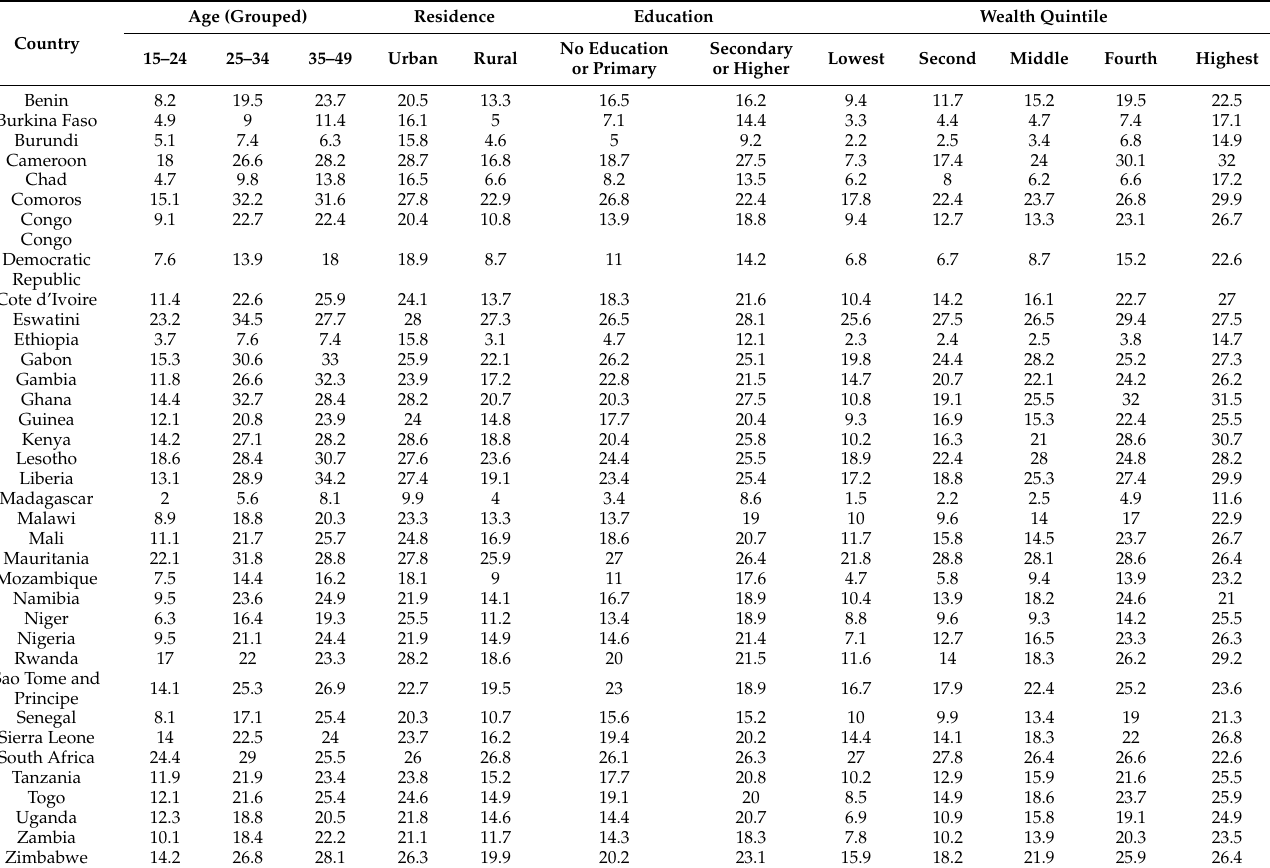
Table 1. Distribution of overweight among women in SSA